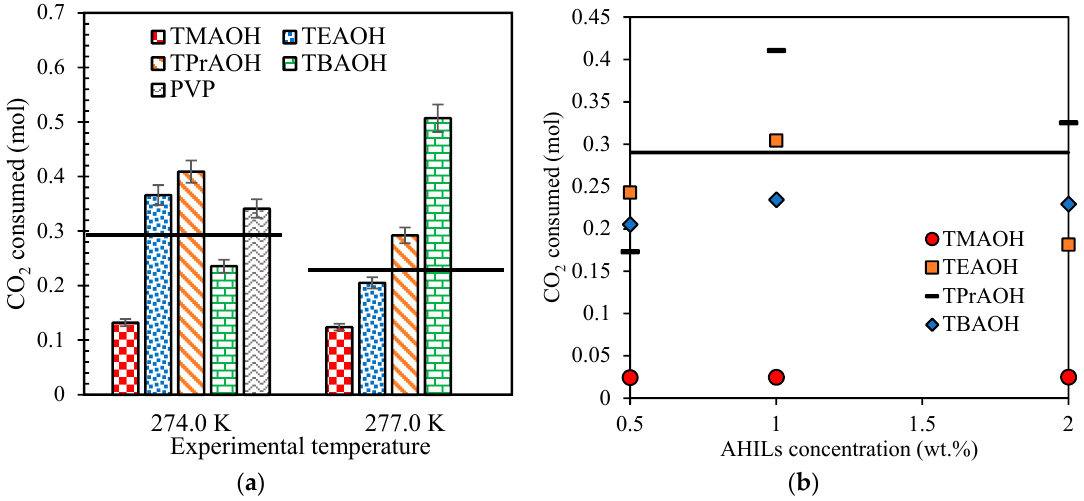
Figure 8. ( a ) E ff ect of AHILs on the measured CO 2 consumed moles at di ff erent experimental temperatures at 1 wt.%; ( b ) E ff ect of AHILs concentrations on the CO 2 consumed moles at 274.15 K; The black line symbolizes pure water values; No hydrate formation was observed for PVP at 277.0 K.